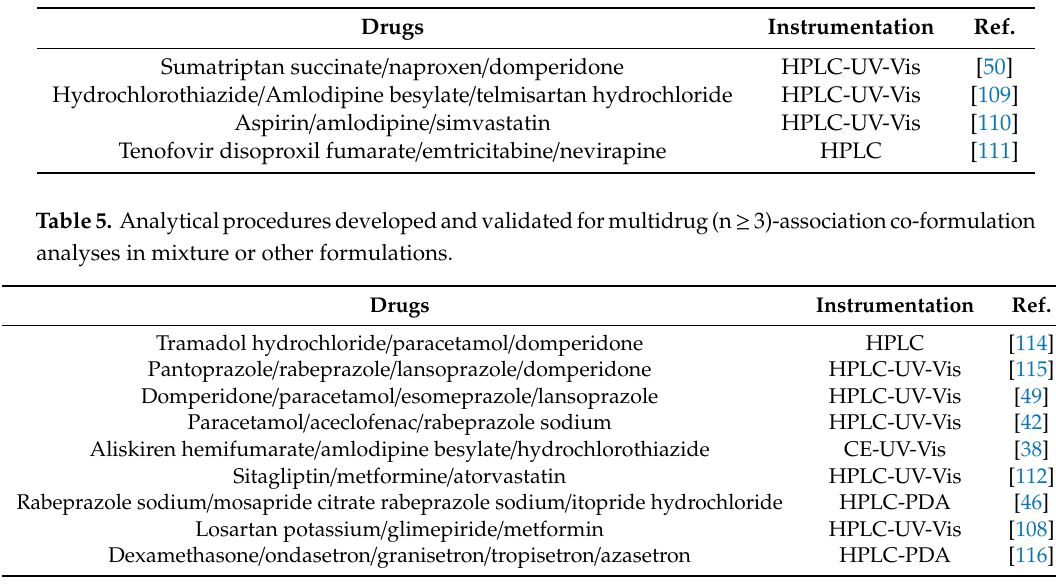
Table4. Analyticalproceduresdevelopedandvalidatedformultidrug(n ≥ 3)-associationco-formulation analyses in tablets.